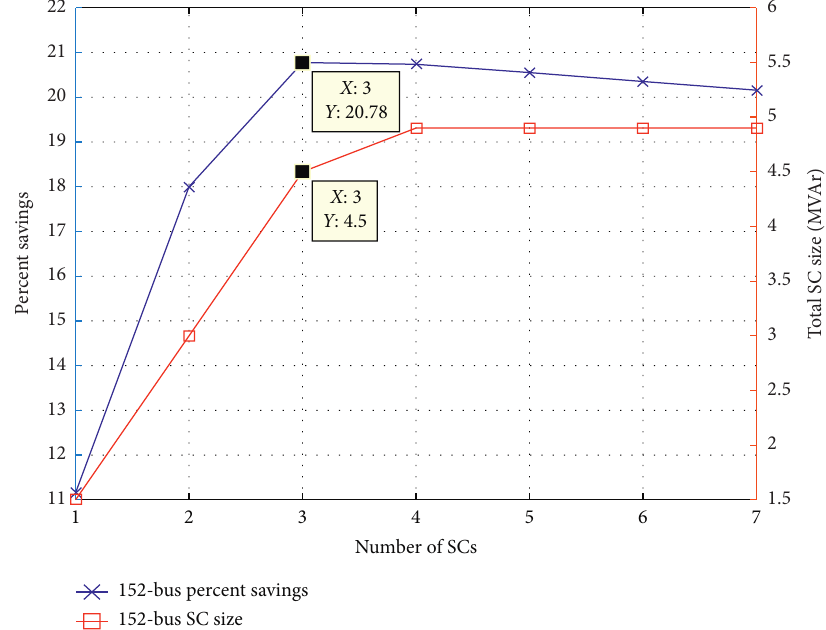
Figure 24: Effect of different numbers of SCs on performance of 152-bus